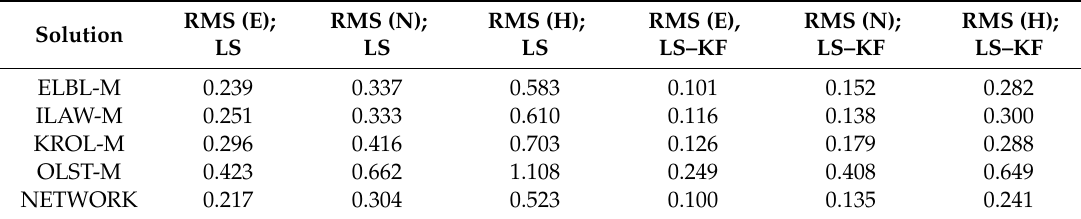
Figure 5. Real errors of network DGPS positioning based on least squares solutions and Kalman filtering, for session II. Table 2. Statistical characteristics of DGPS network positioning results for session II.